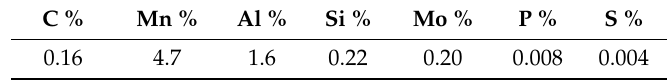
Table 1. Chemical composition of the investigated medium-Mn steel in wt.%.